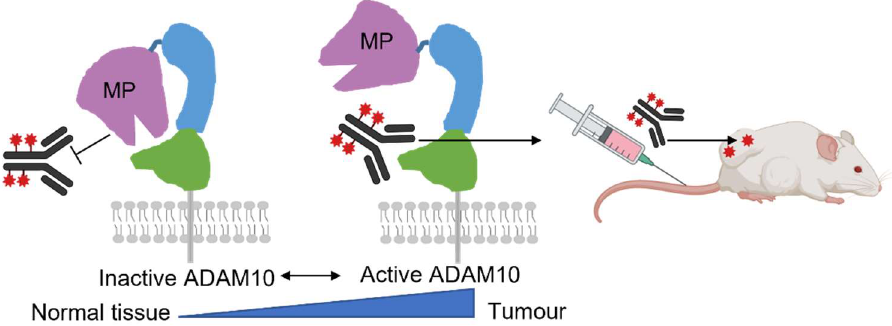
Figure 6. Specificity of mAb 8C7 for an active conformer of the metalloprotease ADAM10 lies in its binding to an epitope in the C domain (green), which is obscured by the metalloprotease domain (MP) in the inactive conformer. Furthermore, 8C7 selectively targets ADAM10 in tumours, and shows improved anti-tumour activity when conjugated to cytotoxic payloads (red).